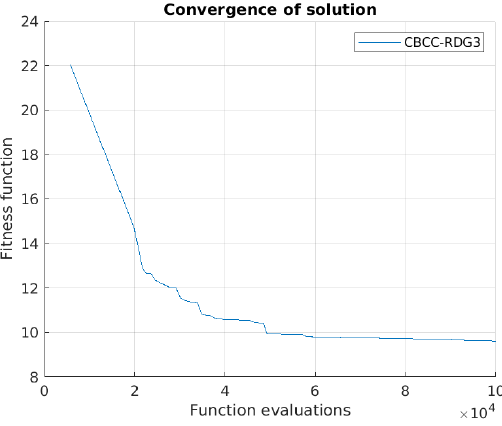
Fig. 4: HyDE-DF, 5 10 4 func. eval- Fig. 5: ×